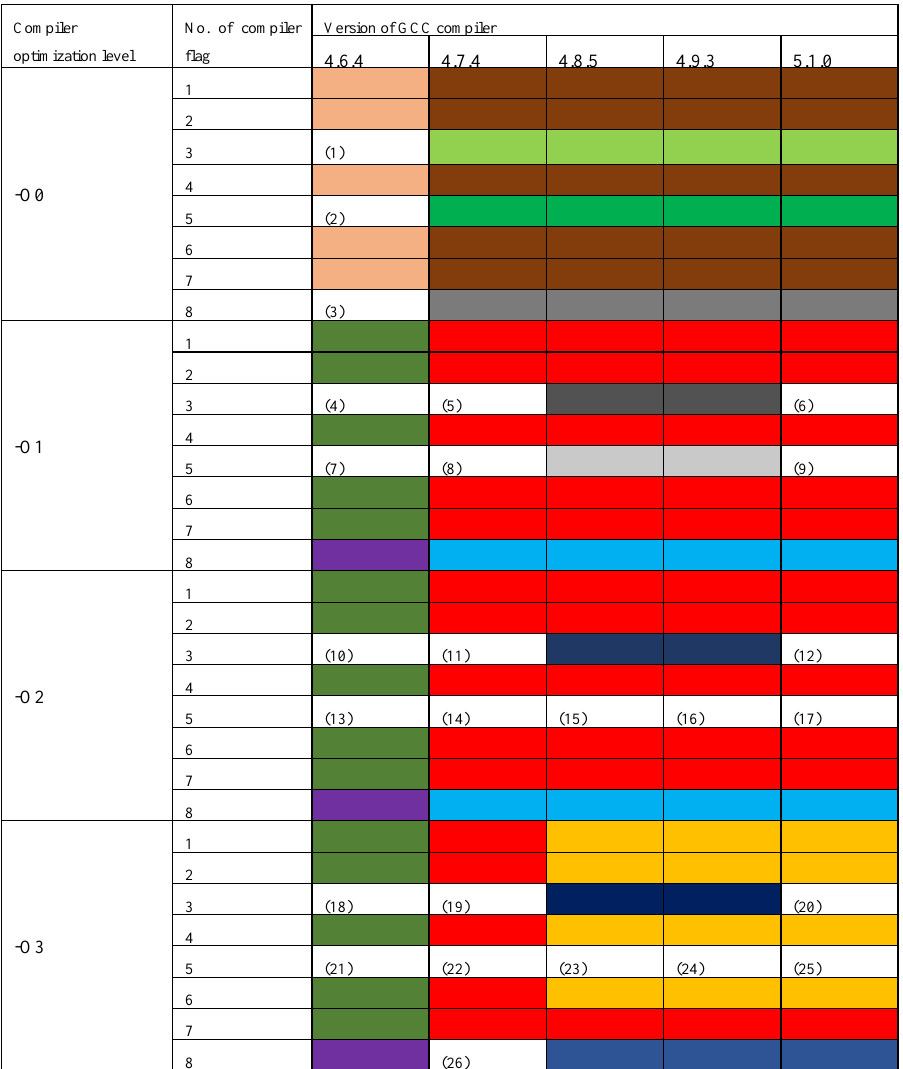
Table 11: Simulation results of CAM5 with various compiling setups of GCC compilers. The compiler flags are given in Table 7. Each color represents a bitwise identical result except the white. A simulation result that emerges only once is in white color with a unique number.